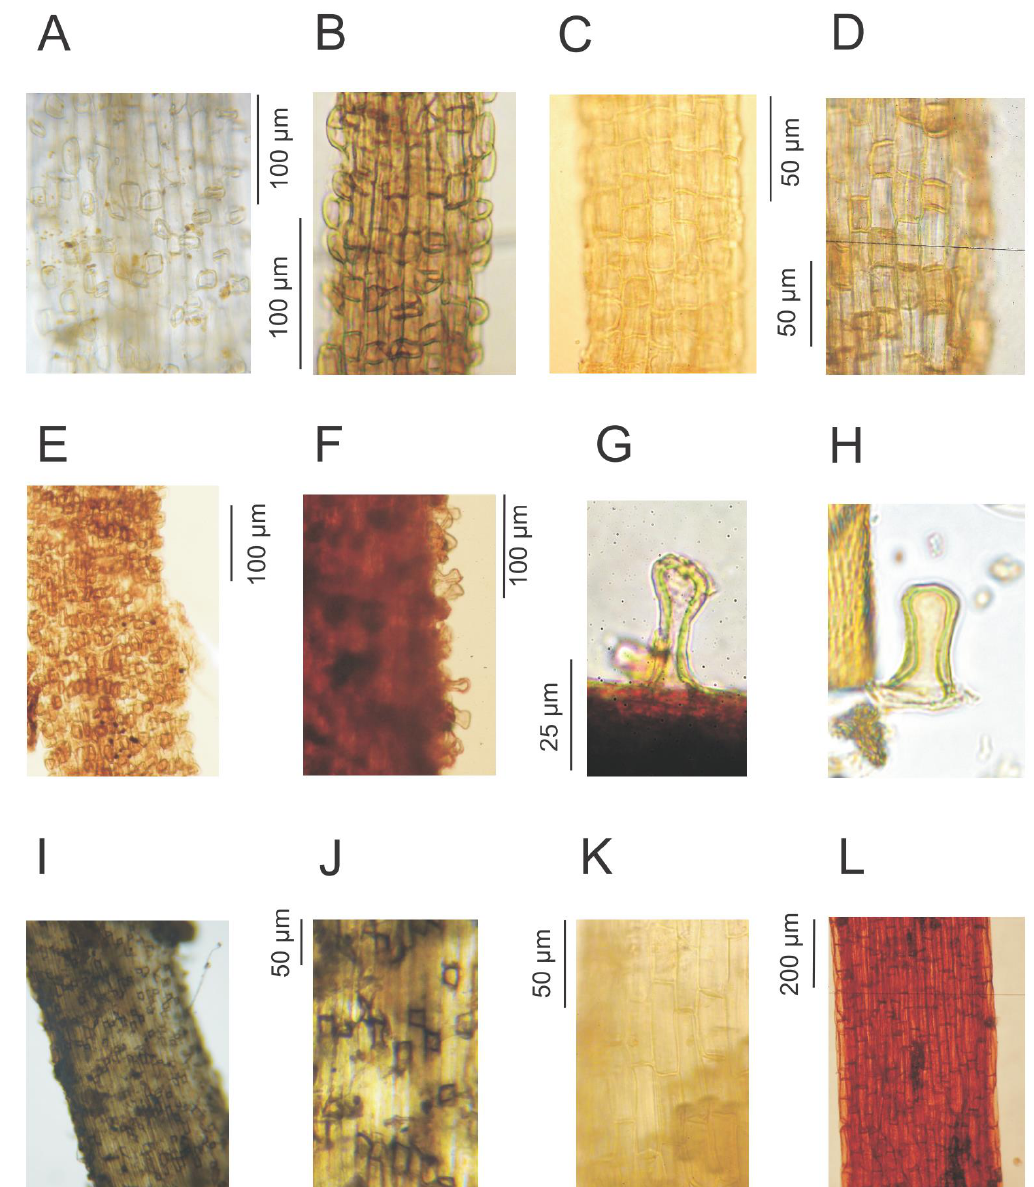
Figure 1. Radicel types: ( A ), ( B ) Carex rostrata type, ( C ) Carex lasiocarpa/rostrata type, ( D